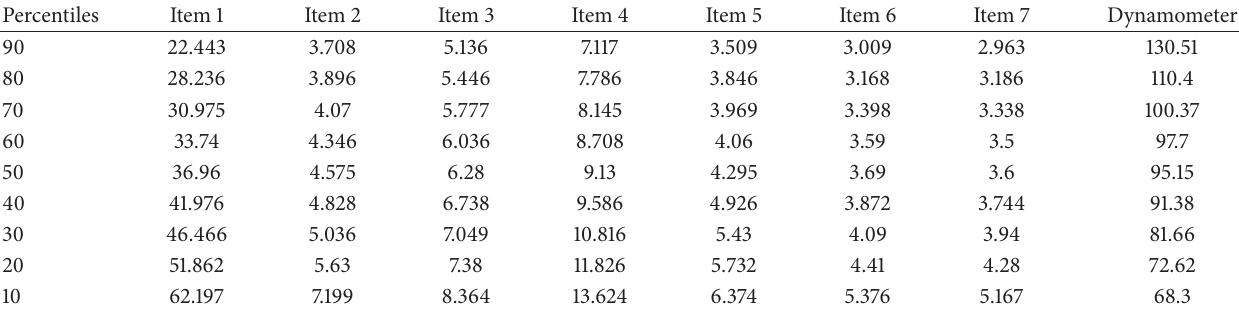
Table 12: 𝑛 = 82 , males, 20–94, nondominant hand, educational instruction: secondary